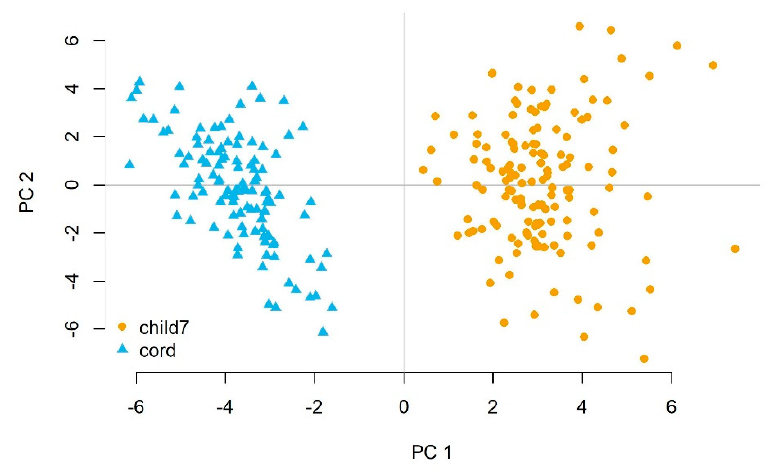
Figure 2. Principal components analysis (PCA) plots of miRNA expression in newborns and 7-year- old children. PCA analysis showed a clear separation of miRNA expression between age groups along the first principal